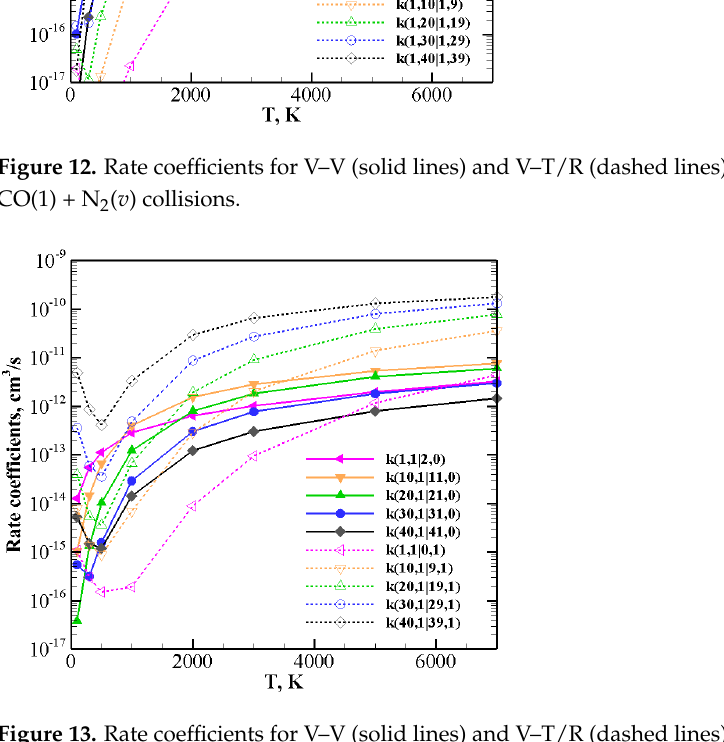
Figure 13. Rate coefficients for V–V (solid lines) and V–T/R (dashed lines) exothermic processes for CO( v ) + N 2 (1)